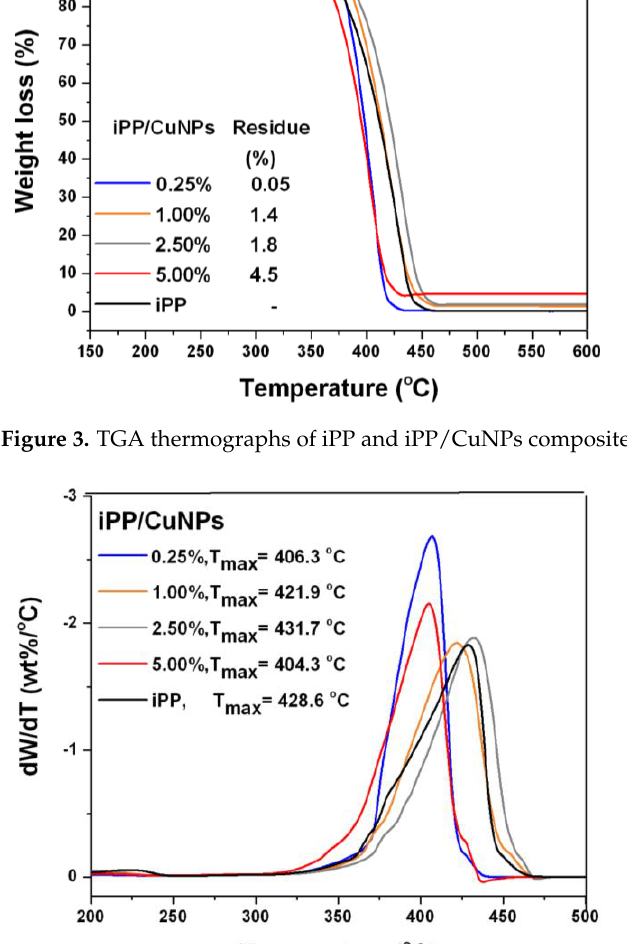
Figure 3. TGA thermographs of iPP and iPP/CuNPs composites.